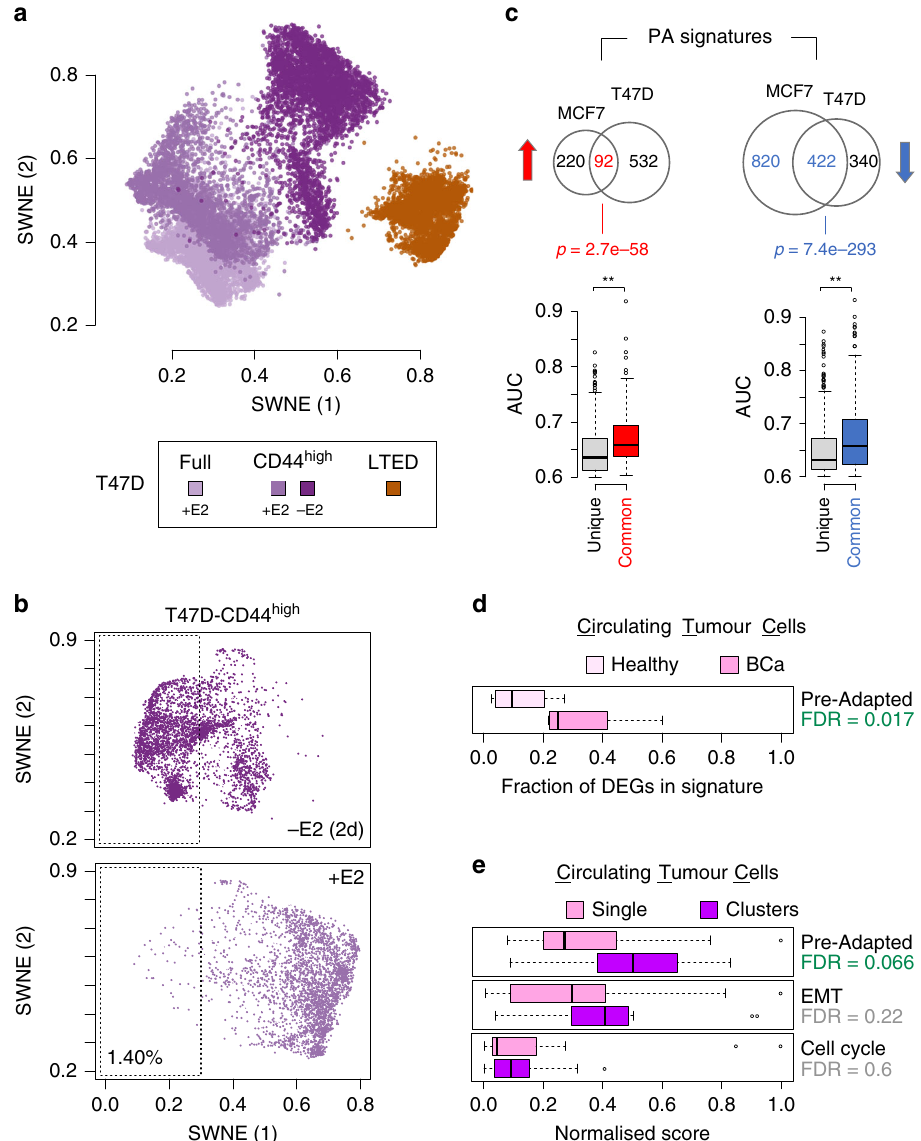
Fig. 7 Evidence for pre-adaptation in T47D and circulating tumour cells. a Bi-dimensional representation of 15,805 transcriptomes from single T47D and LTED cells (Supplementary Table 2) (SWNE; k = 20). b Dimensionality reduction of single-cell transcriptional pro fi les of oestrogen-supplemented ( + E2; top) or deprived ( − E2; 2 days) T47D-CD44 high cells. Pre-adapted (PA) cells highlighted in boxes. c (Top) Venn diagrams showing the overlap between the MCF7-PA and T47D-PA signatures (upregulated genes in red; downregulated in blue). P -values of the overlaps calculated via hypergeometric test. (Bottom) Box plots indicating the effect size (AUC) of those genes unique to either MCF7- or T47D-PA or common to both. ** p < = 1e-5 (Wilcoxon rank- sum test). d Expression of the PA signature in circulating tumour cells (CTCs) compared with blood specimens from healthy donors. e Expression of the PA, the epithelial-to-mesenchymal transition (EMT) and a cell-cycle signatures in clusters of CTCs compared with single CTCs. False discovery rates estimated by permutations. Box plots show median, interquartile values, range and outliers (individual